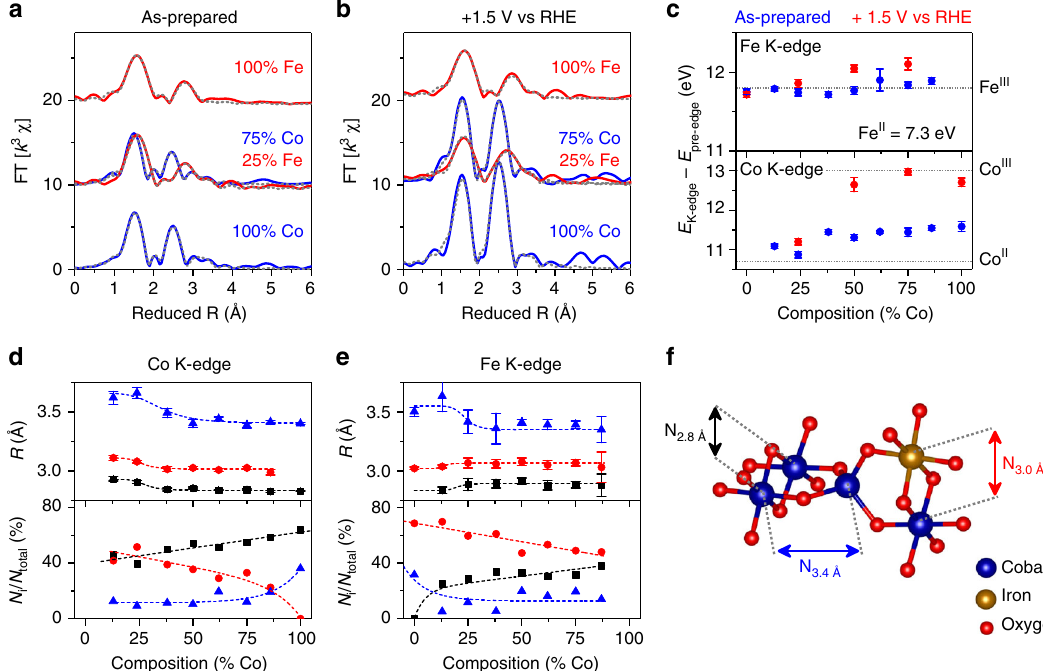
Fig. 3 Structural analysis of the Fe – Co oxide by X-ray absorption spectroscopy. a , b Fourier-transform of the fi ne-structure region for Co and Fe K-edges in the as-prepared and oxidized states. Simulation results are represented by the dashed gray lines. c Difference in energy between the pre-edge feature and the K-edge for Fe and Co in the as prepared and oxidized states. Values obtained from crystalline reference compounds are marked (Supplementary Fig. 3). Error bars represent the standard deviation between all individual spectra for a given composition. d , e Bond lengths and relative structural contributions of the three unique M – M coordination shells for the Co and Fe K-edges of as-prepared catalyst fi lms. Dashed lines are included to facilitate visualization of the trends. Error bars were calculated as described in Supplementary Note 3. f Hypothetical structure for visualization of the three distinctive Co – M structural motifs utilized in EXAFS simulations. Label colors in f correspond to data in d ,